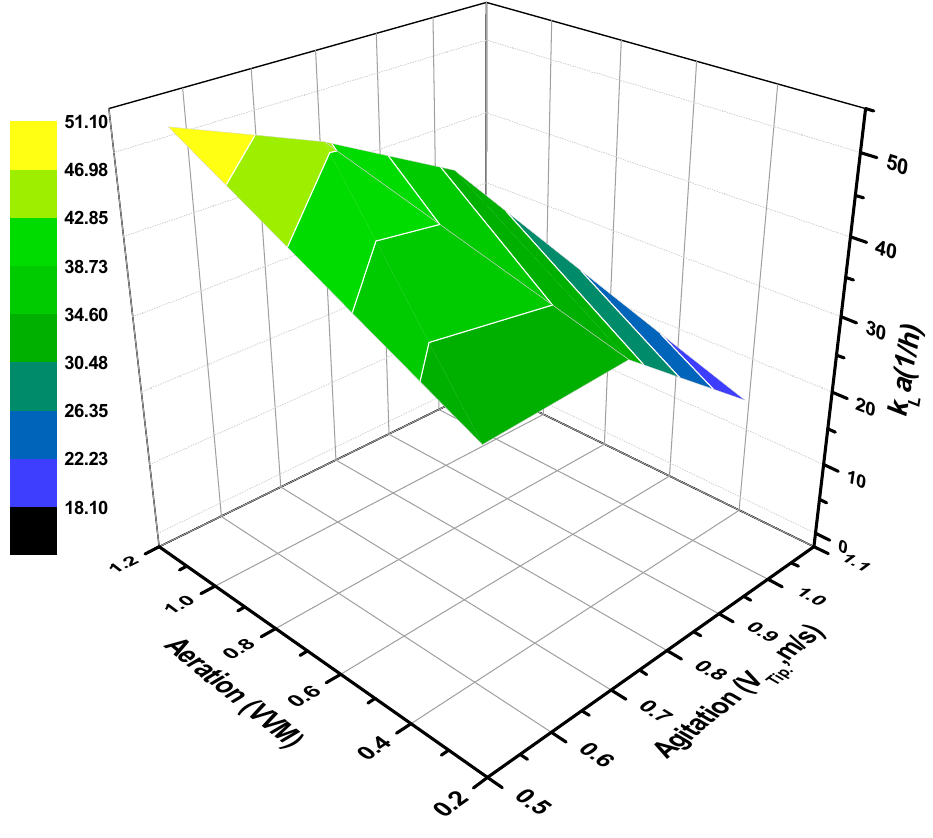
Figure 3. Response surface methodology of k L a behavior as a function of impeller tip velocity (m/s) and aeration (vvm).